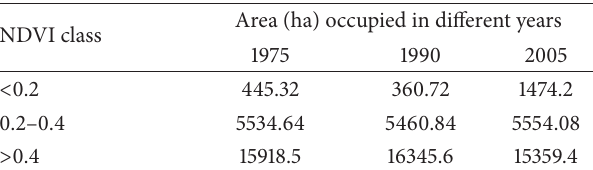
Table 4: Area occupied by different NDVI classes in different years in the 3km buffer area surrounding dense road points in SBR.